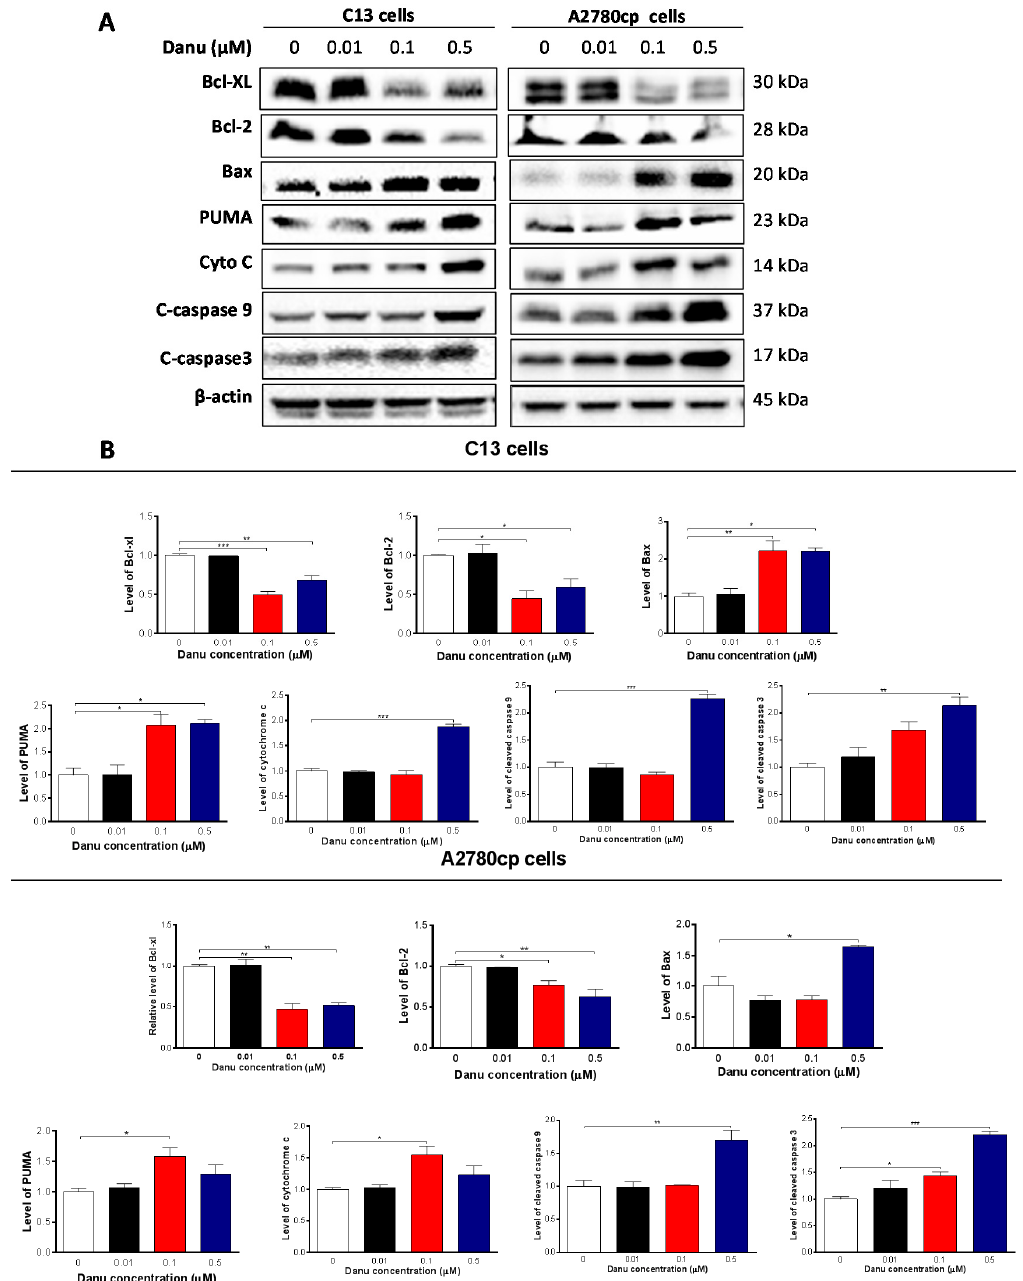
Figure 7. Danu alters the expression of pro-apoptotic and anti-apoptotic proteins in C13 and A2780cp cells. C13 and A2780cp cells were incubated with Danu 0.01, 0.1, and 0.5 μ M for 48 h and the protein samples were subject to Western blotting assay. ( A ) Representative blots of B-cell lymphoma-extra large (Bcl-xl), B-cell lymphoma 2 (Bcl-2), Bcl-2-like protein 4/Bcl-2-associated X protein (Bax), p53 up-regulated modulator of apoptosis (PUMA), cytochrome c, c-caspase 9, and c-caspase 3 in C13 and A2780cp cells and ( B ) bar graphs showing relative expression level of Bcl-xl, Bcl-2, Bax, PUMA, and cytochrome c, c-caspase 9, and c-caspase 3 in C13 and A2780cp cells. β -actin was used as the internal control. Data represent the mean ± SD of three independent experiments. * p < 0.05, ** p < 0.01, and *** p < 0.001 by one-way analysis of variance.